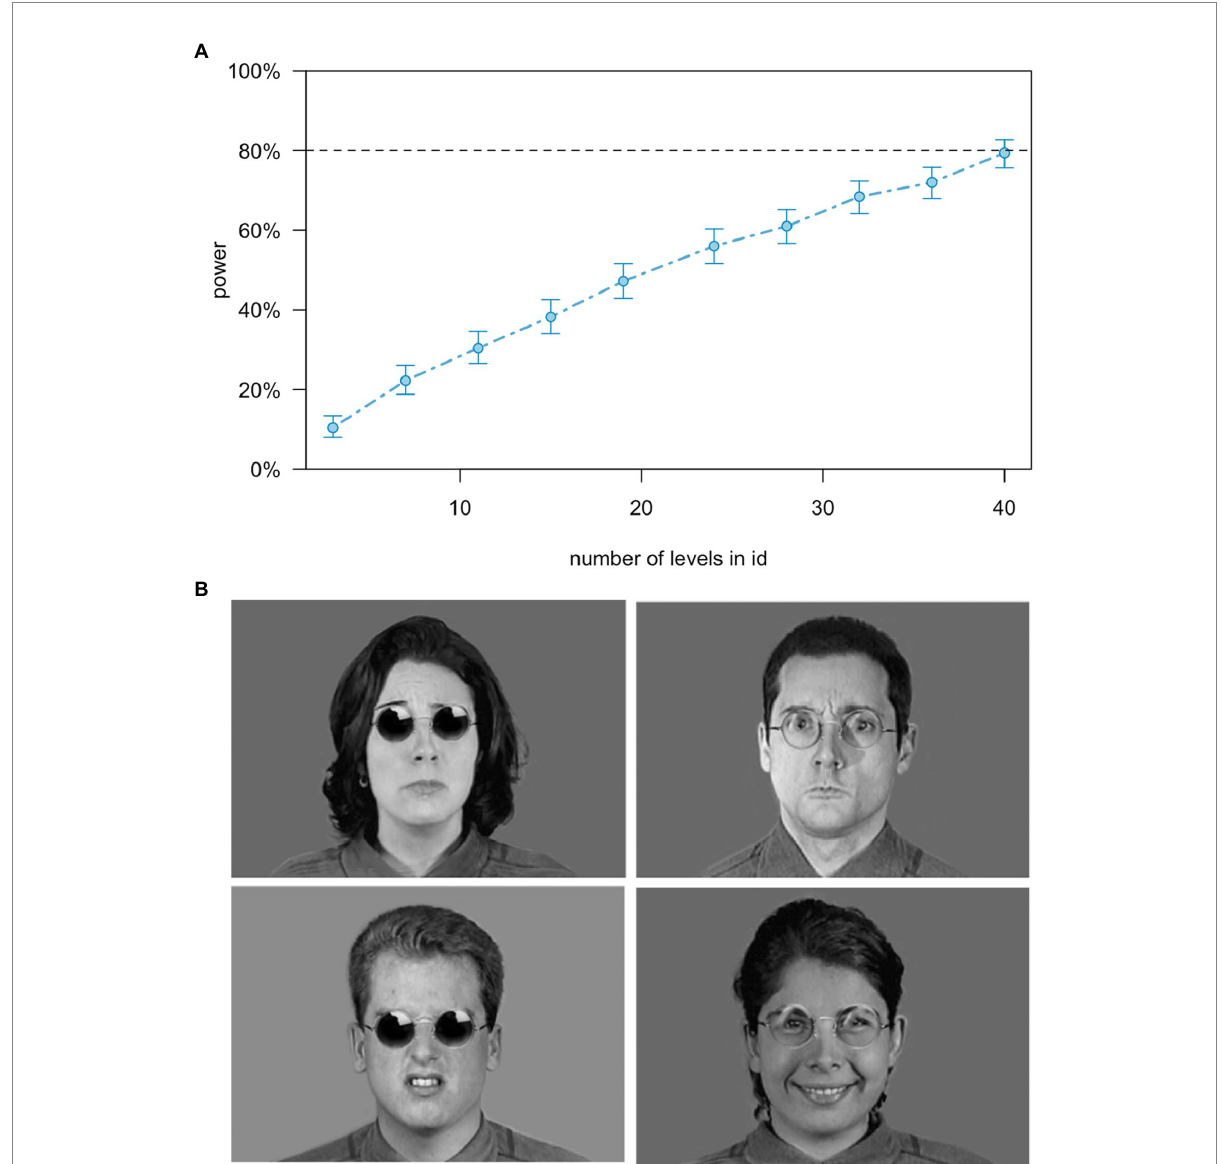
FIGURE 1 Power curve to estimate the minimum sample size based on data from a pilot study in our laboratory with averted vs. direct gaze (A) and example stimuli for each eye contact and each emotion taken from the Montreal Set of Facial Displays of Emotion (Beaupré et al., 2000). Obstructed eye contact (left) and unobstructed eye contact (right), and of sadness (top left), anger (top right), disgust (bottom left), and happiness (bottom right) (B)